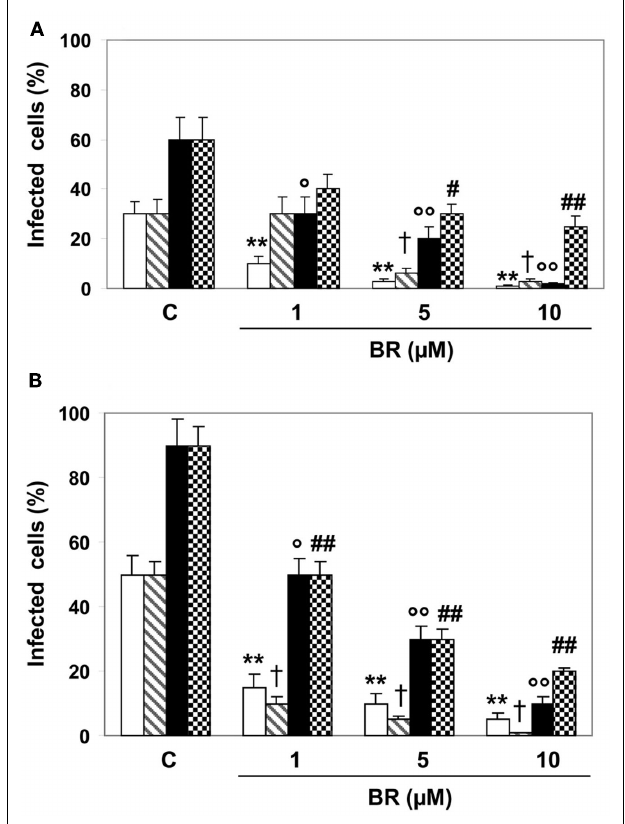
FIGURE 3 | Effect of bilirubin (BR) and albumin-bound bilirubin (BR–HSA) given concurrently with herpes simplex virus type 1 (HSV-1) and enterovirus EV71 and how this affects viral replication. Hep-2 (A) andVero (B) cells were exposed to BR (1–10 μ M) alone or complexed with saturating HSA (20 μ M) and concomitantly infected with HSV-1 and EV71 (1 × 10 5 PFU) for 2h. At the end of incubation the inocula were removed and the cells incubated in culture medium for 24 (white and dashed columns) or 48h (black and dotted columns). Both dashed and dotted columns refer to HSA treatment as described in the Section “Materials and Methods.” Data are expressed as the percentage of infected cells, mean ± SEM of six individual samples per group. * P < 0.05 versus control (C) after 24h from infection; ** or † P < 0.01 versus respective controls after 24h from infection; ˚ or # P < 0.05 and ˚˚ or ## P < 0.01 versus respective controls after 48h from